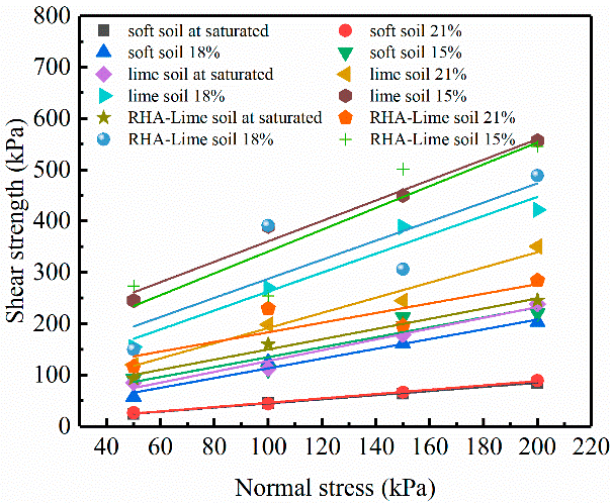
Figure 6. Relationship between shear strength and vertical pressure.